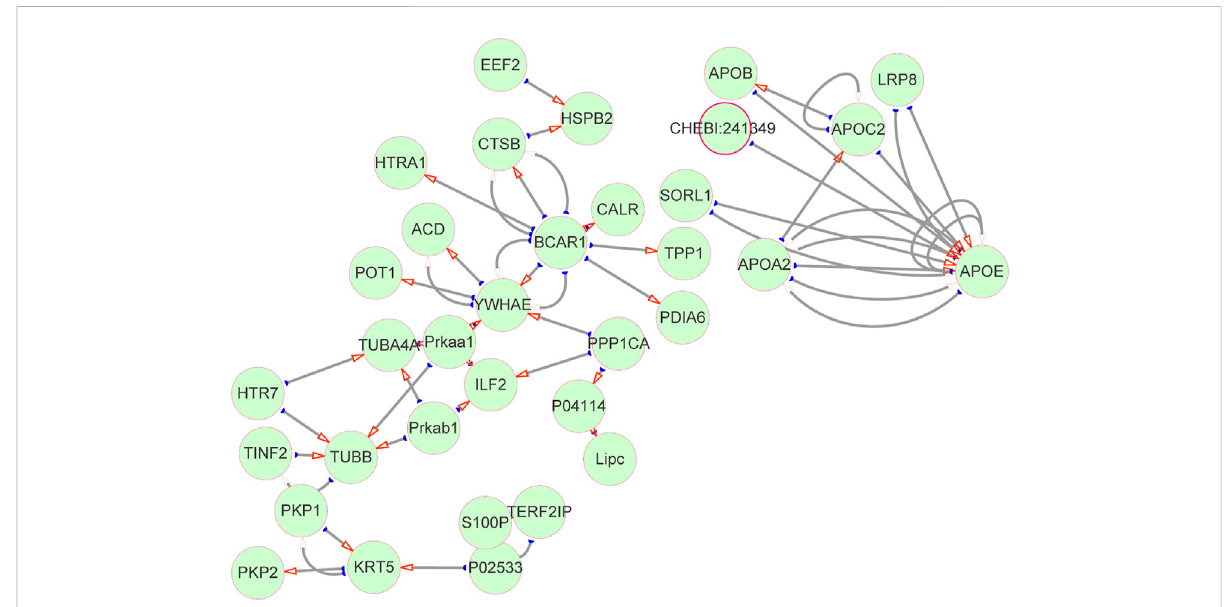
FIGURE 5 Protein – proteininteractionnetwork.DEPsinteractionnetworkdiagram.Thegreencirclesrepresentproteins,andtheredarrowspointtotarget proteins (target proteins of DEPs), and the corresponding ones are source proteins (DEPs).